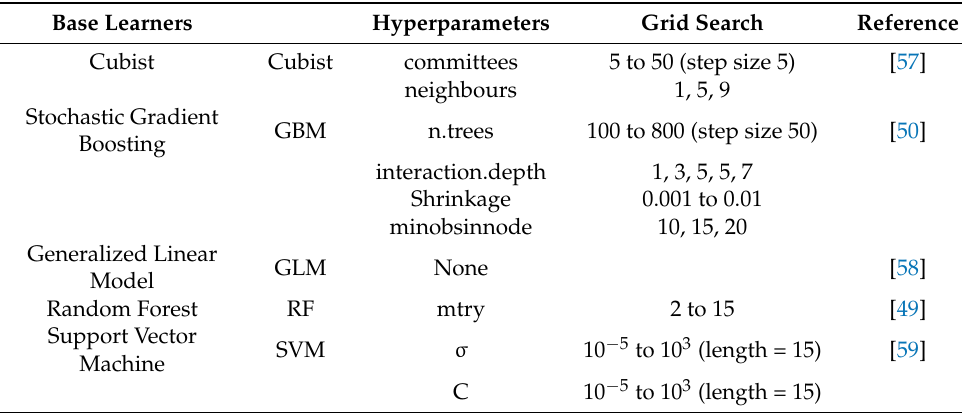
Table 1. List of models and corresponding hyperparameters in